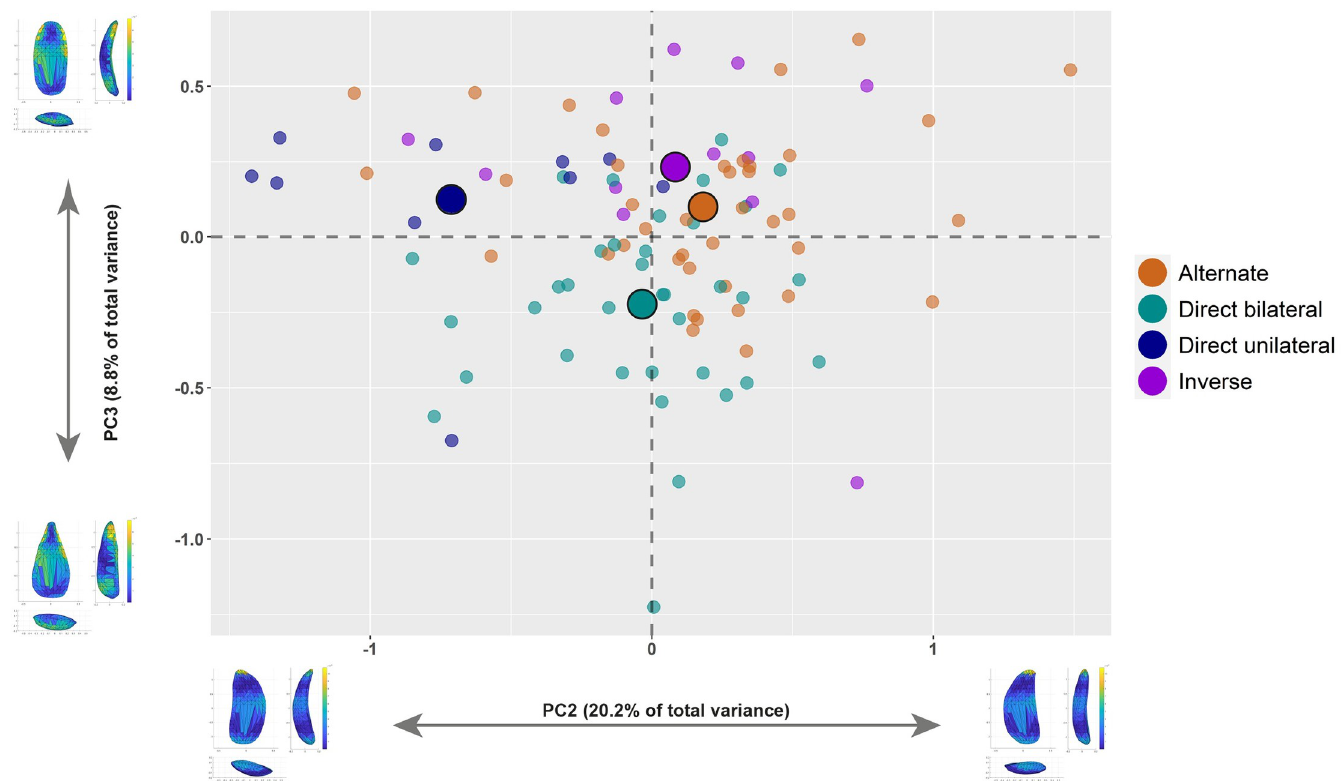
Fig 8. Bivariate plot of the second and third principal components (PC2 versus PC3) of retouched bladelets sorted according to retouch position. The illustrations in the x and y axes of the plot describe the variation of hypothetical shapes of blanks situated at the extremes of each principal component. Illustrations were created with the Warp tool in AGMT3-D. The mean of each group in the plot are identified with bigger dots. For colors see the